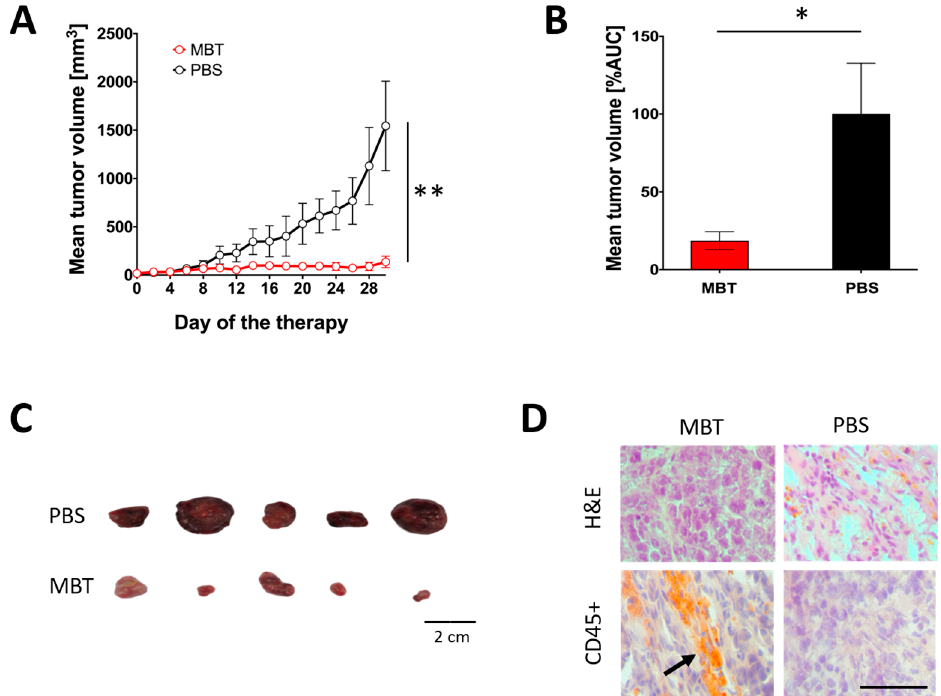
Figure 4. Significance of innate immunity in MBT immunotherapy in subcutaneous PHEO. B6.CB17-Prkdc scid /SzJ mice were subcutaneously injected with MTT-luciferase cells. After tumors grew to the desired size (about 50 mm 3 ), mice were randomized into two groups ( n = 6/group): (i) the group treated with MBT and (ii) the group treated with PBS. MBT and PBS were given intratumorally on days 0, 1, 2, 8, 9, 10, 16, 17, 18, 24, 25, and 26. Tumor volume was measured with a caliper. ( A ) The tumor volume growth is presented as a growth curve (** p < 0.01 against PBS) and ( B ) as an area under the curve (AUC) (* p < 0.05 against PBS). ( C ) Surviving mice were sacrificed on the 30th day of therapy (five mice from the MBT-treated group and five mice from the PBS-treated group), and tumors were documented. ( D ) Hematoxylin and eosin (H&E) staining and CD45 + immunohistochemistry staining were performed on tumor cryosections (a thickness of 8 µm). Bar = 20 µm.